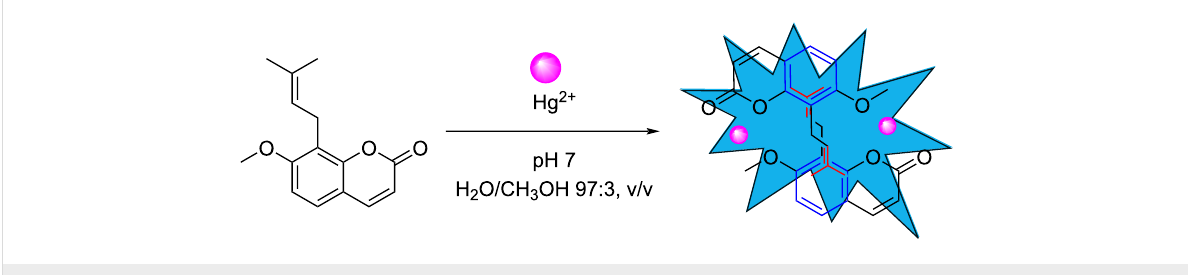
Figure 7: The binding mode of OST and Hg 2+ .